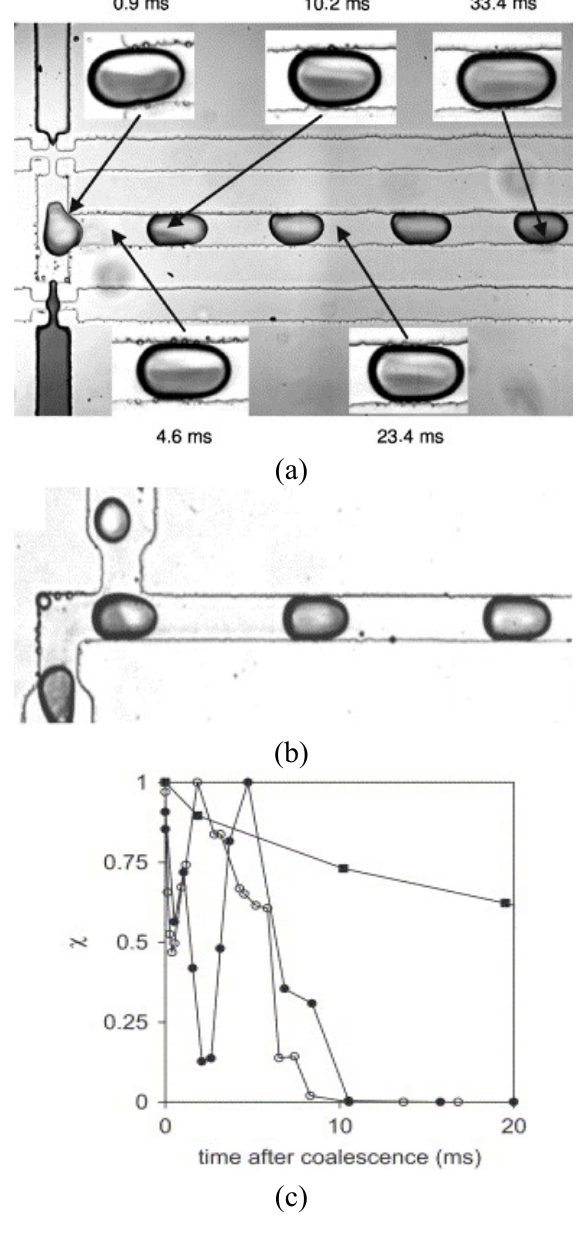
Figure 27. Coalescing of two droplets in a (a) side-by-side and (b) longitudinal arrangement. Mixing performance is plotted in (c) : ■ , mixing of dye and water in a side-by-side coalescence configuration; ● , mixing of dye and water in a longitudinal coalescence configuration; ○ , bleaching reaction in a longitudinal coalescence configuration. Here a low χ level of means a better mixing effect (from Sarrazin et al.